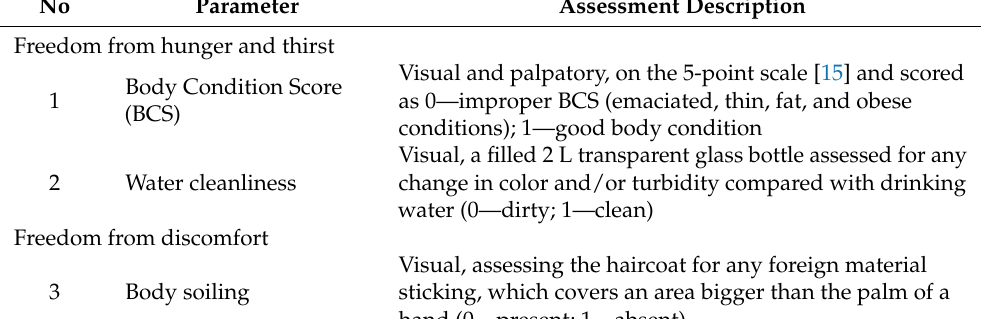
Table 1. Parameters and scoring in the welfare assessment of the 32 studied